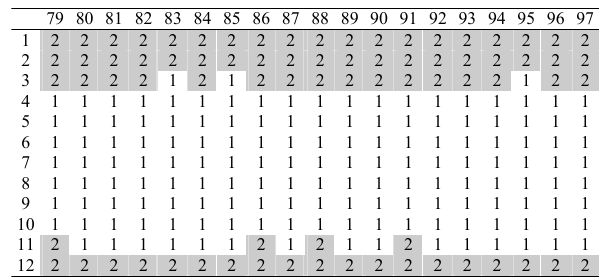
Table 2. As in Table 1 except for SH; the summer type (2) is shaded Table 3. As in Table 1 but for 8 rotated PCs of raw data. The summer type (1) is shaded